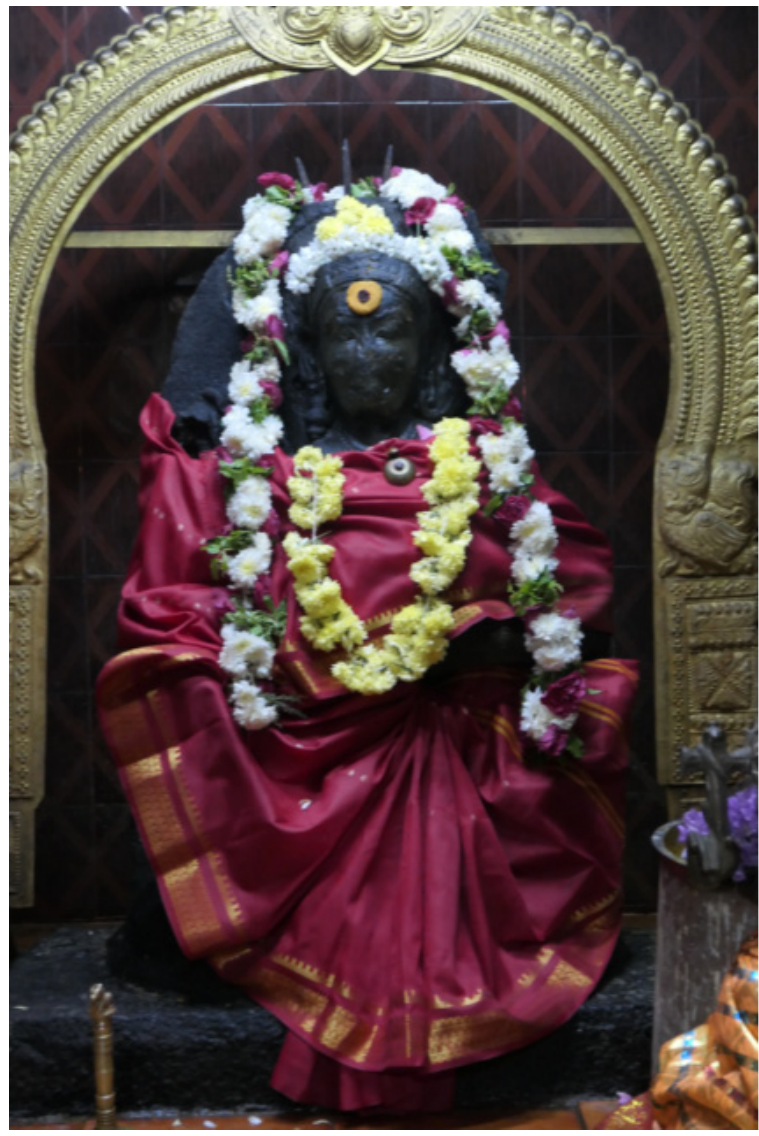
Figure 17. Yogini/Goddess, Kanchi, Tamil Nadu. Photograph by Katherine E. Kasdorf. Now we could see the contours of the goddess’s open eyes and arched brows, the finely articulated ornamentation on her headdress, the long earrings and curls of wild hair framing her face, and her multiple necklaces barely revealed by a fold in her pomegranate- colored sari. Although the sculpture has sustained visible damage, it is still deemed wor- thy of worship. An elderly woman tending the shrine kindly raised the goddess’s gar- ments to let us see that the legs are crossed at the ankles, just like the others from the group. The size of the sculpture corresponds well with the Tamil yoginis, and she has specific features that reminded us of individuals from the group (Figure 18). She wears a makara-shaped earring in her left ear, like the NMAA yogini. The spiral-shaped ends of her loose hair are similar to the curls of many yoginis from the group, including the one at NMAA. Her cheeks are incised with circles like the yogini in Minneapolis (Figure 19). The correspondences spoke for themselves—this had to be one of the yoginis.